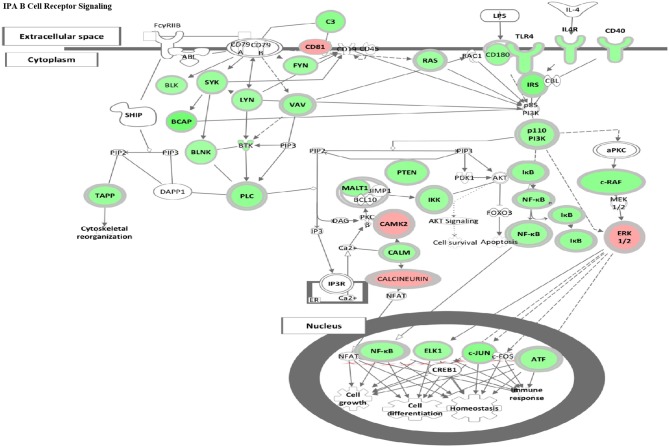
HDAC6 inhibition repressed B cell signaling pathways in NZB/NZW mice. The IPA Canonical Signaling Pathway “B Cell Receptor Signaling” had a Z score of −3.1. Transcripts differentially expressed between HDAC6 inhibitor treated and untreated NZB/NZW mice were overlaid on genes in the IPA pathway. Decreased transcripts are shown in green, while increased transcripts are shown in pink.